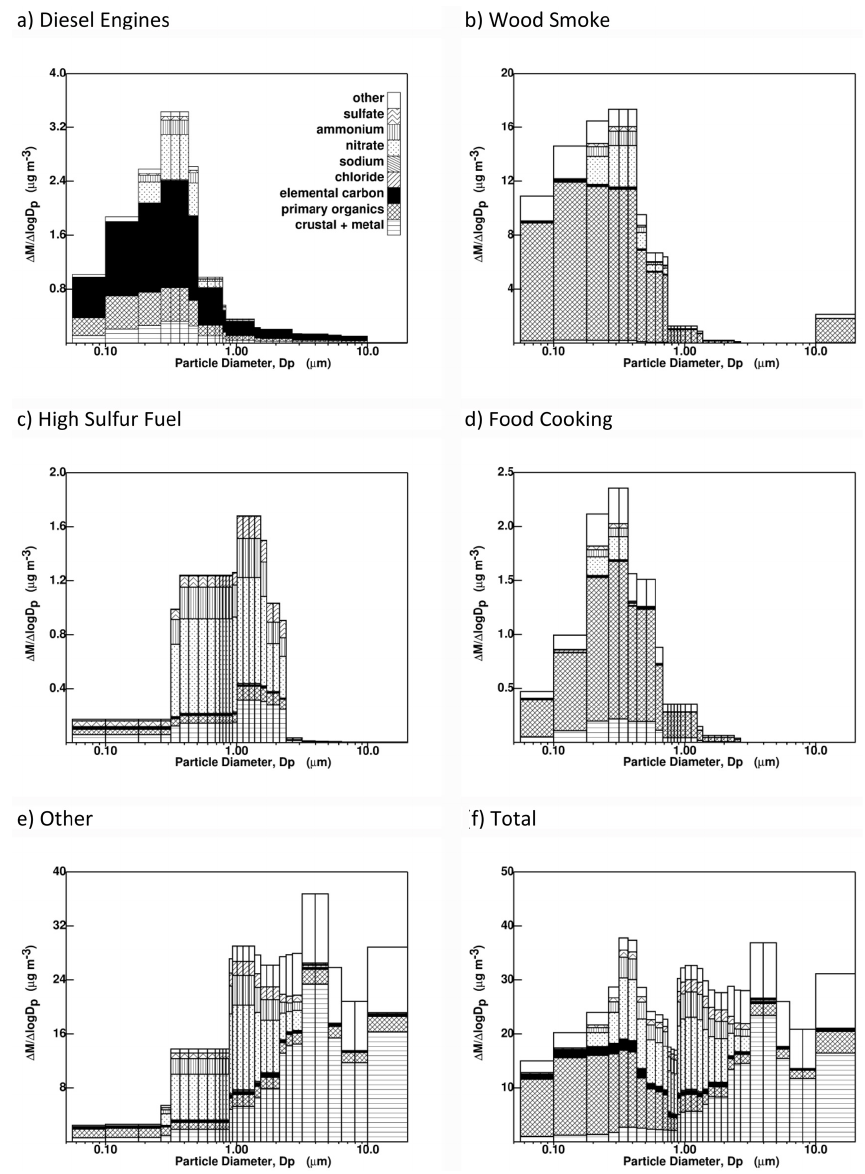
Fig. 4. Size distribution plot of the source-oriented external mixture particulate representation averaged from 12:00 to 13:00LT on 24 De- cember 2000 in Fresno, California. All five of the sources included in the simulations of the current study are presented in panels a–e along with the total size distribution in panel f . The 8 moving model size bins from each source are mapped to 32 standard size bins to facilitate a comparison with internally mixed results in Fig. 3. Note that the maximum value of each panel is adjusted to best show the particle size